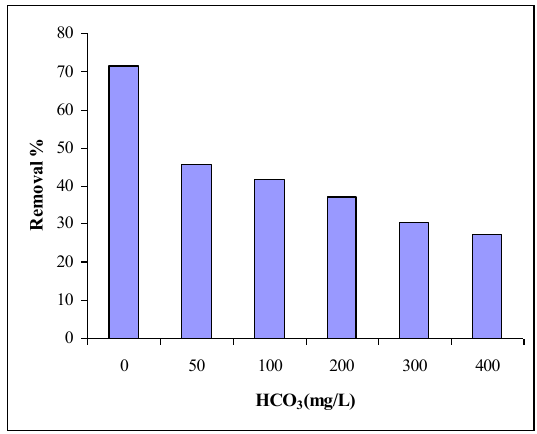
Figure 3 . Comparison of removal percentage for degradation of diazinon in the presence of sulfate pH=3;Time=180 S;H